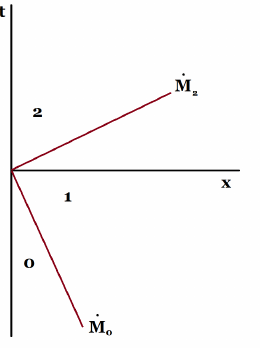
Figure 1. Areas of